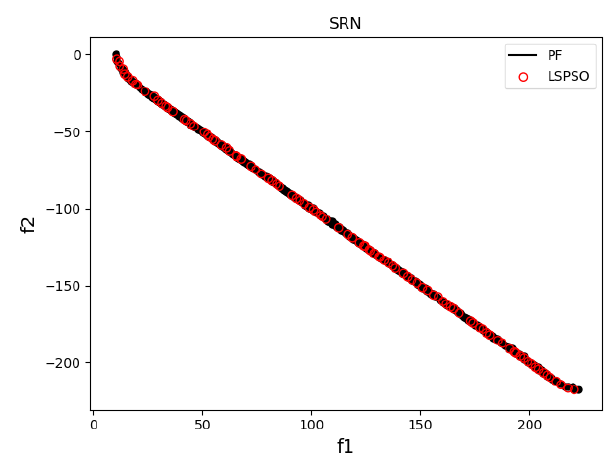
Figure 4. Pareto optimal solutions obtained by LSPSO for SRN.